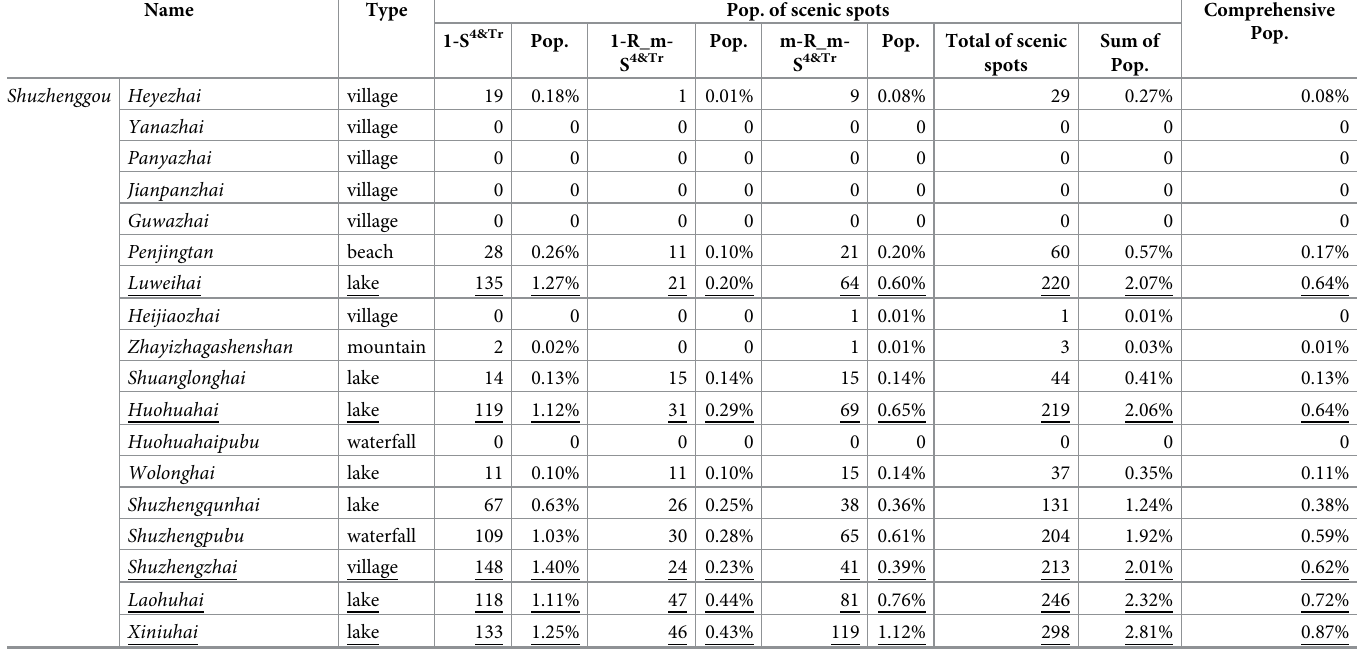
Table 5. Calculated results of TDP (abbreviated pop.) at Jiuzhaigou scenic spot scales.